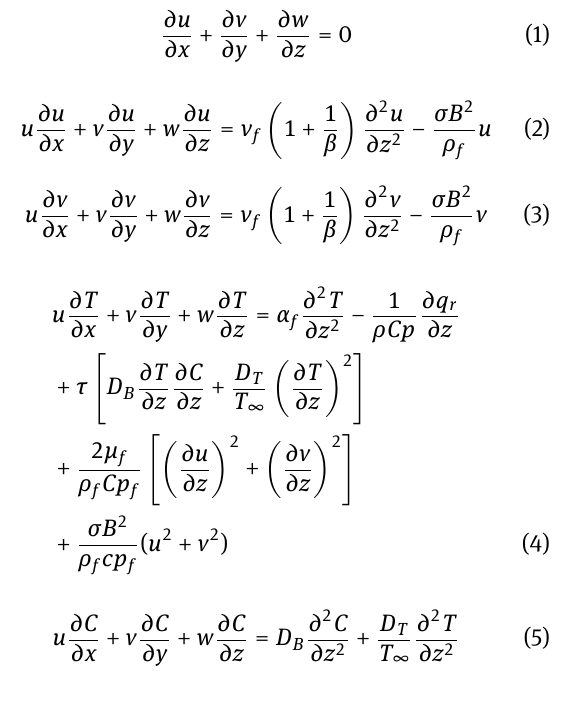
We also assume the rheological equation of Casson fluid reported by Mukopadyaya [16] √ (cid:40) 2 (cid:0) µ + p / 2 π (cid:1) e > π y B ij , π